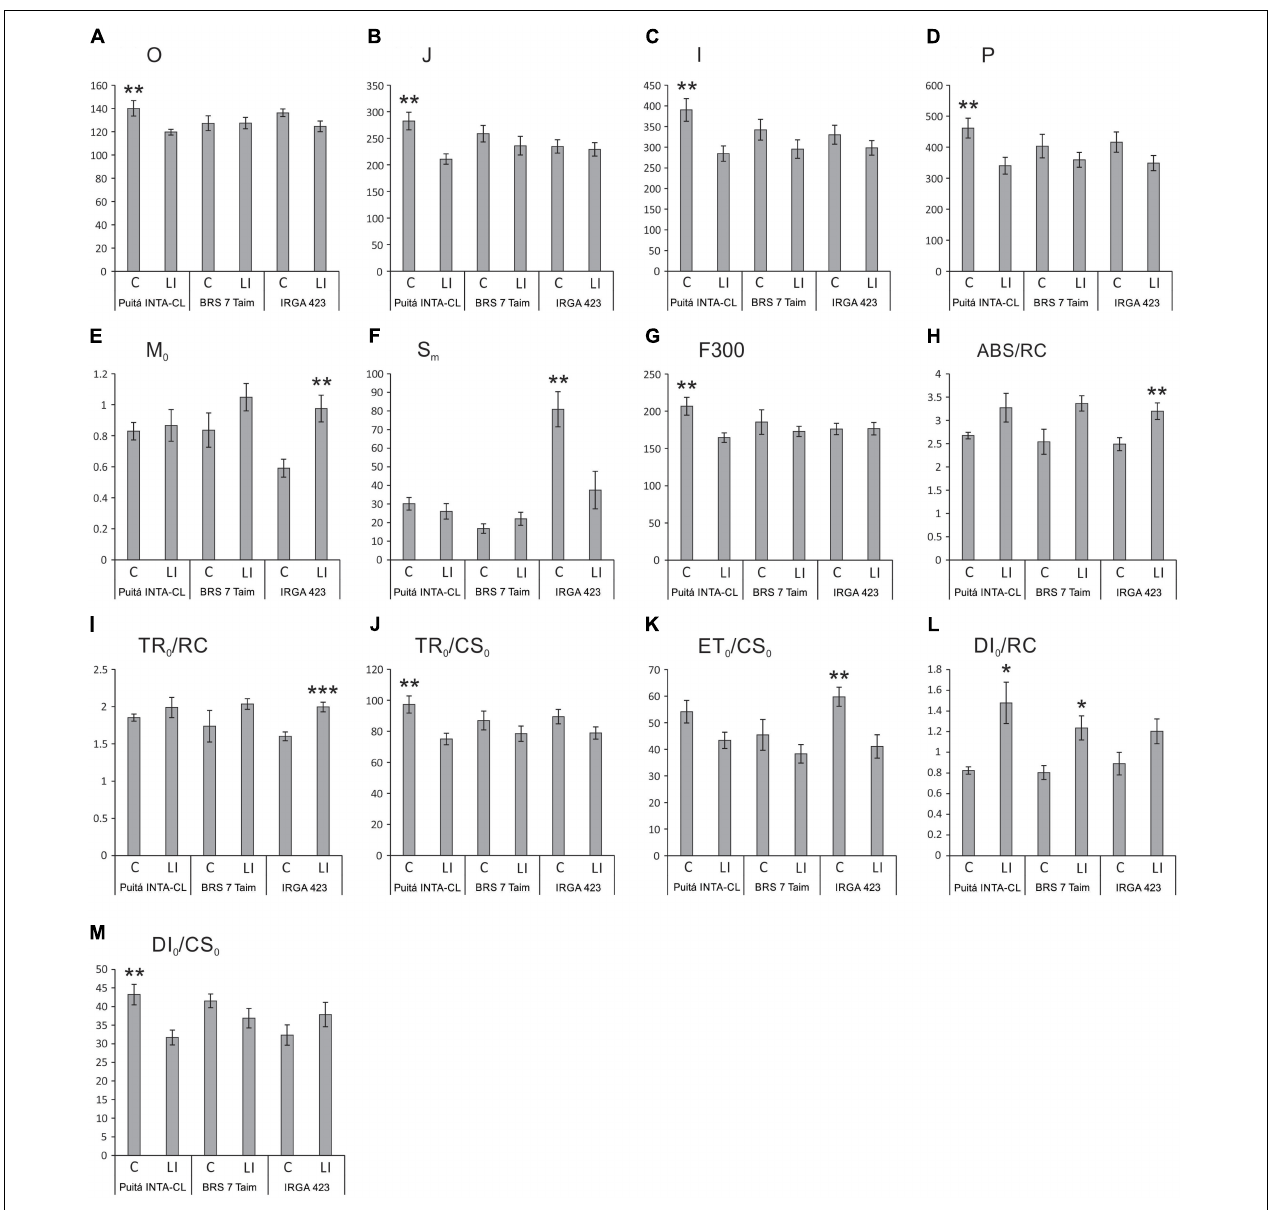
FIGURE 2 | OJIP-test parameters calculated from the chlorophyll a fluorescence transient in control (C) and late infested (LI) leaves of the three tested cultivars, (Puitá INTA-CL, BRS 7 Taim, and IRGA 423). (A) O, (B) J, (C) I, (D) P, (E) M 0 , (F) S m , (G) F300, (H) ABS/RC, (I) TR 0 /RC, (J) TR 0 /CS 0 , (K) ET 0 /CS 0 , (L) DI 0 /RC, and (M) DI 0 /CS 0 . Represented values are the averages of 10 samples ± SE. Mean values (from each cultivar) with one, two, or three asterisks are significantly different as determined by the Student’s t -test ( P ≤ 0.05, 0.01, and 0.001,